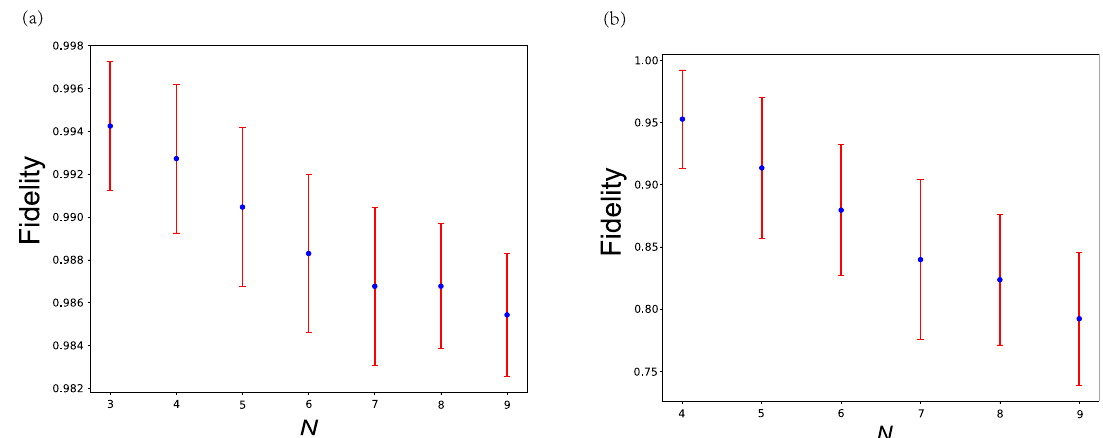
= 2, K = 30, M = 6, r = 0.9, η = 0.5, η = 0.9; ( b ) N = 3, K = 30, M = 6, ind t cut